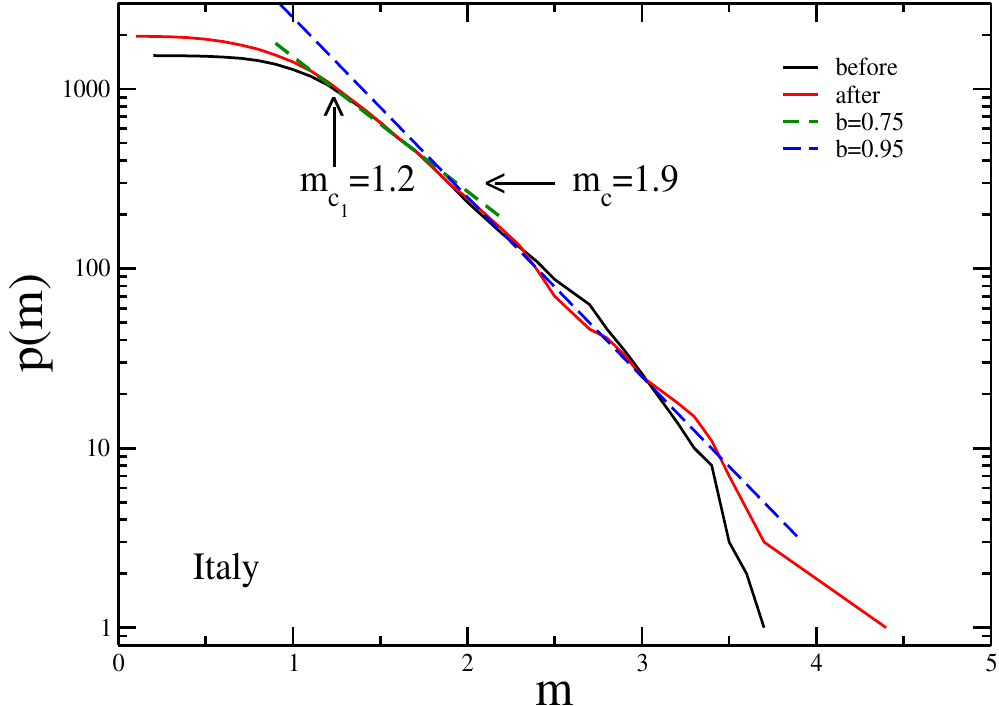
Figure 1. The Gutenberg–Richter distribution for the Italian catalogue. The blue dashed line repre- sents the fit for m ≥ m c = 1.9. The green dashed line represents the fit in the interval 1.2 ≤ m ≤ 1.9 (see text for